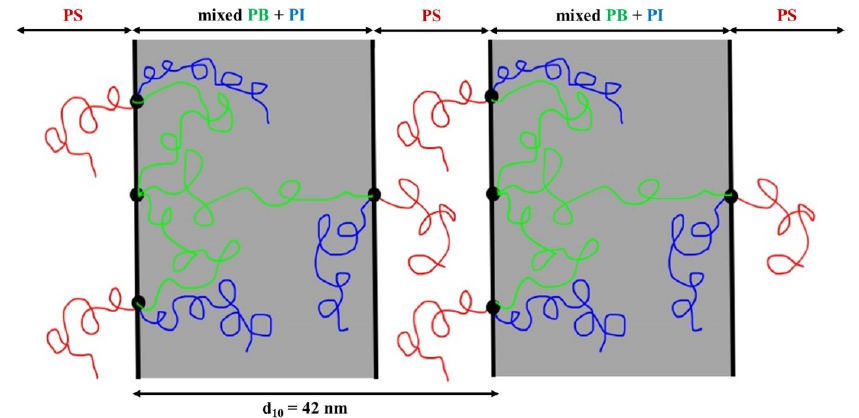
Figure 4. Schematic illustration of the di ff erent segments’ arrangement of the [(PS)(PI)(PB)] 3 -B 3 core type dendritic terpolymer.